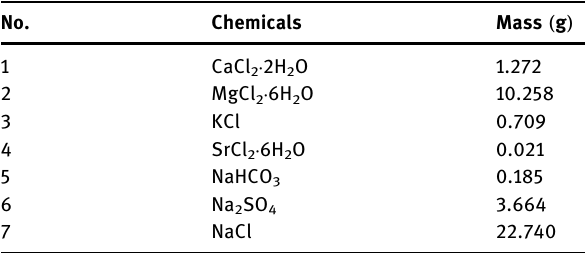
Table 2: Salt composition of Field X synthetic brine for 1 L volume No.